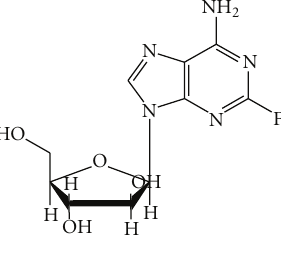
Scheme 1: Chemical structure of fludarabine.